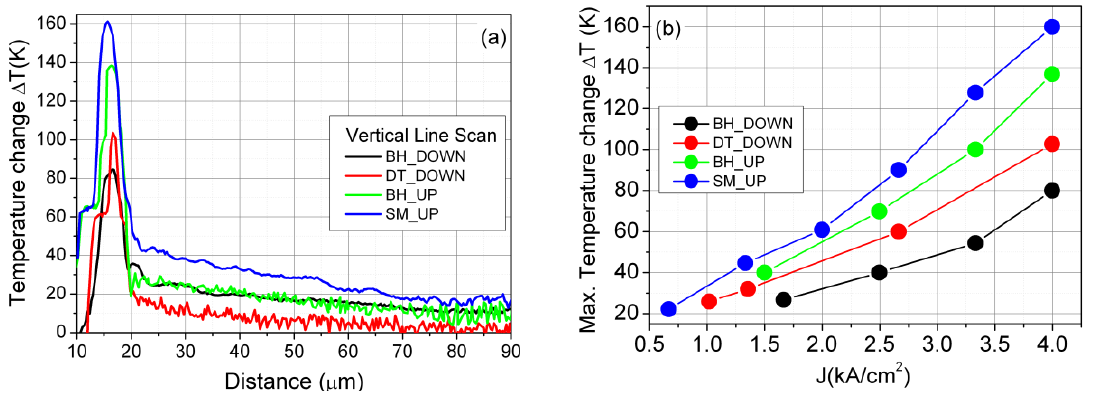
Figure 7. ( a ) Temperature distribution line scans across the laser facet, taken at the center of the active area perpendicular to the epitaxial layers and ( b ) maximum temperature increases as a function of current density for all investigated types of QCLs.